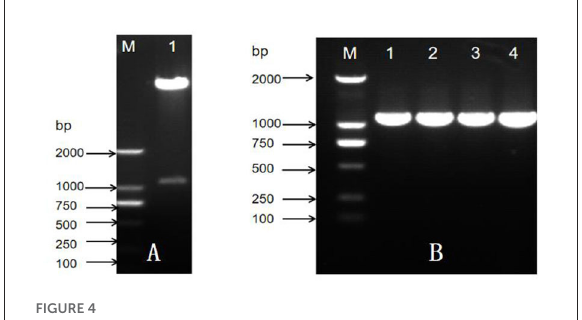
FIGURE4 Construction and verification of plant expression vector. (A) Restriction enzyme analysis of plant expression vector, M: DNA maker ladder; 1: plasmid vector. (B) PCR assay of Agrobacterium EHA105 single colony, M: DNA maker ladder; 1–4: EHA105 single